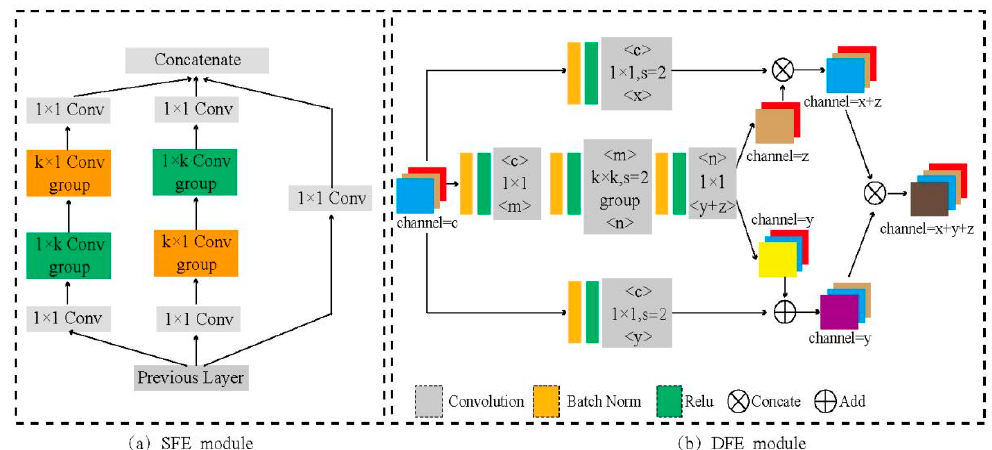
Figure 3. Feature Enhancement Module, in which each conv box denotes a Conv + BN + ReLu processing. ( a ) Shallow Feature Enhancement Module and ( b ) Deep Feature Enhancement Module.